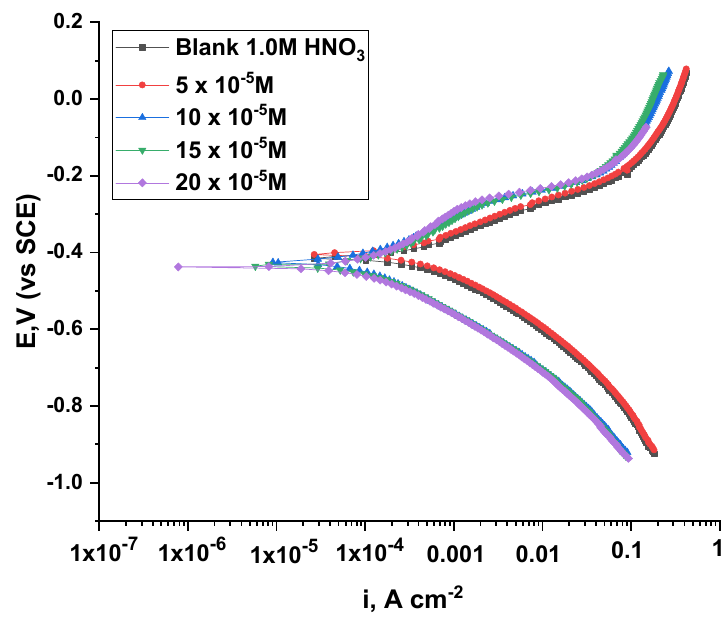
Figure 12. Plots of PP of Cu dissolution with and without different doses of ACR-2.